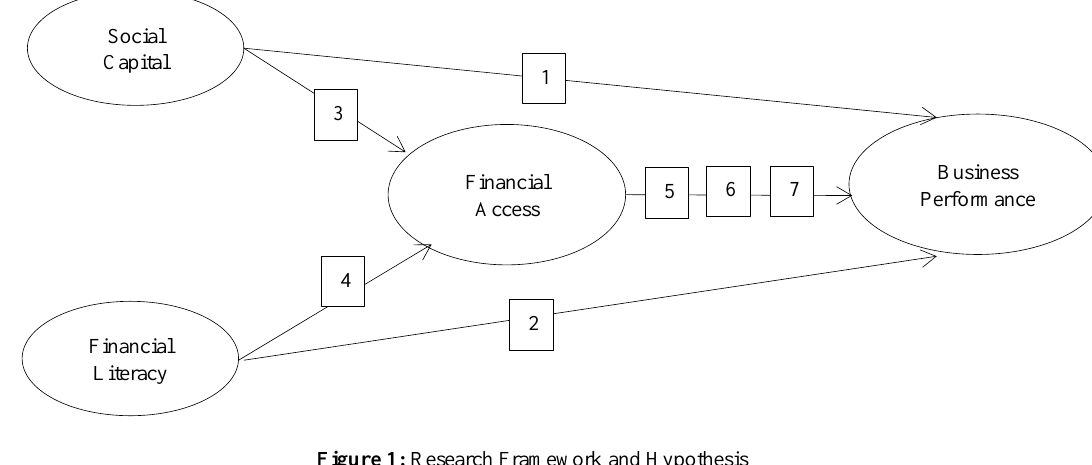
Figure 1: Research Framework and